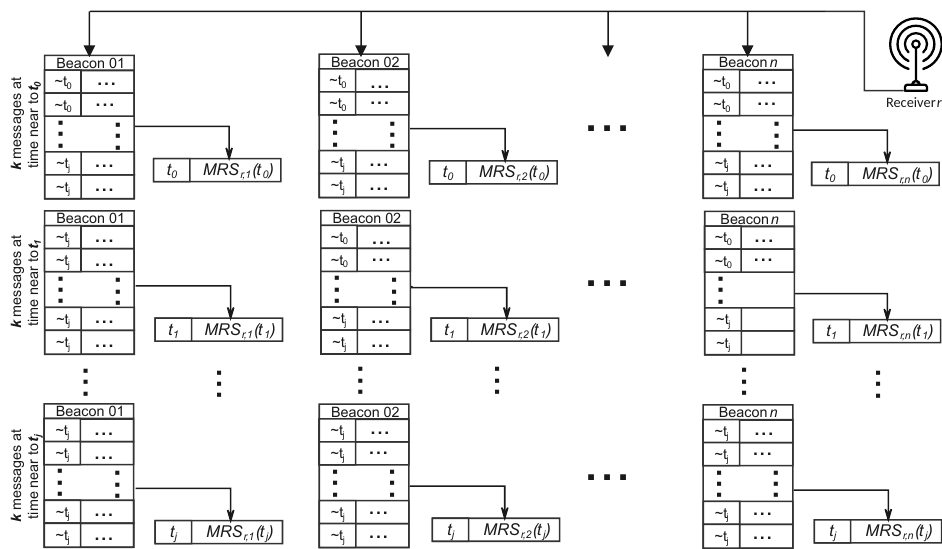
Figure 4. Graph of data collection and subsampling in a generic receiver r . The samples sent by each beacon are grouped in chunks of k , a representative sample is selected as the median element of the k samples and keeps its timestamp (see text). The symbol ∼ t j means “approximately t j ”, that is, all samples from the same group of k have similar